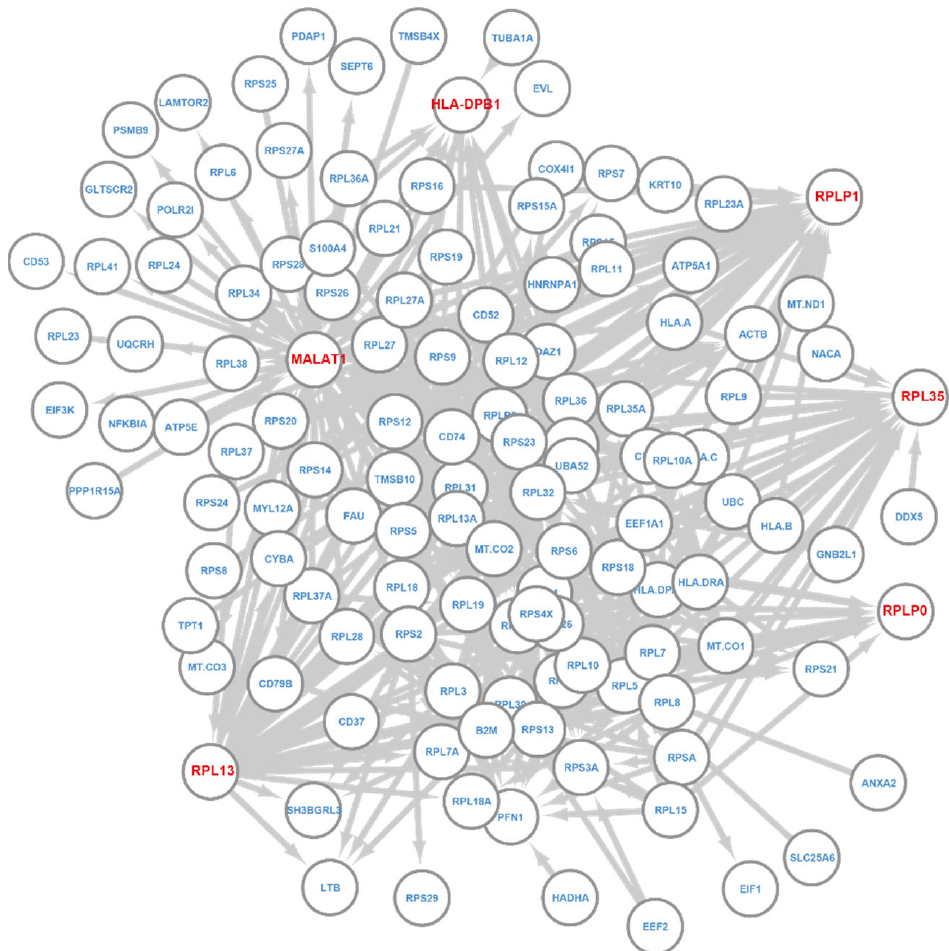
Figure 6. T ‐ GEM regulatory network for NK cell. Nodes are informative genes and their associated Key genes. Links go from Key to Query genes. Genes with red color are hub genes.